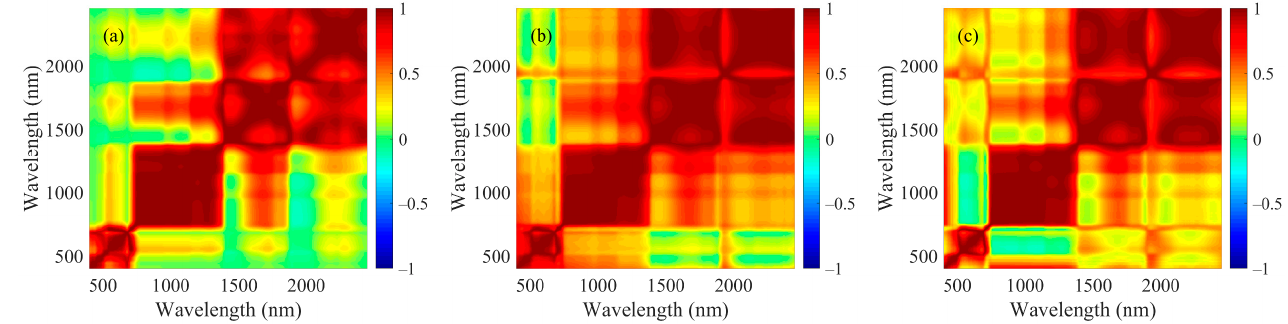
Figure 9. The linear correlation coefficients between different spectral bands in three datasets: ( a ) Simulation dataset. ( b ) Dataset A. ( c ) Dataset B.